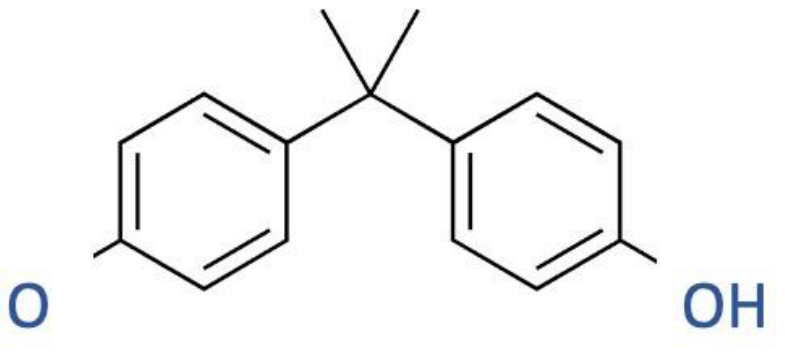
Figure 2. Chemical structure of BPA.